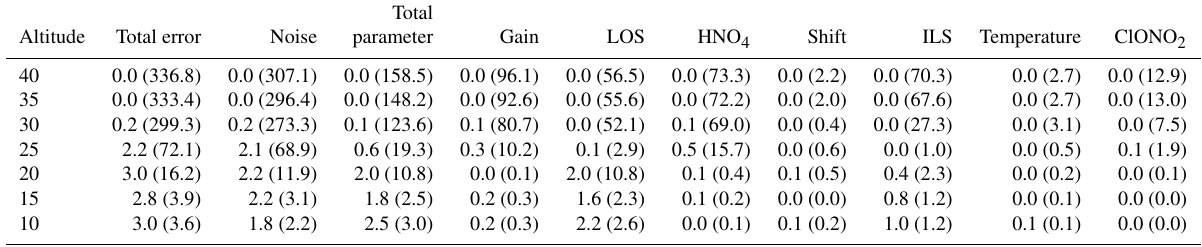
Table A5. Error estimates for a polar summer profile during the RR period. Errors are given in pptv (relative errors in %). Total Altitude